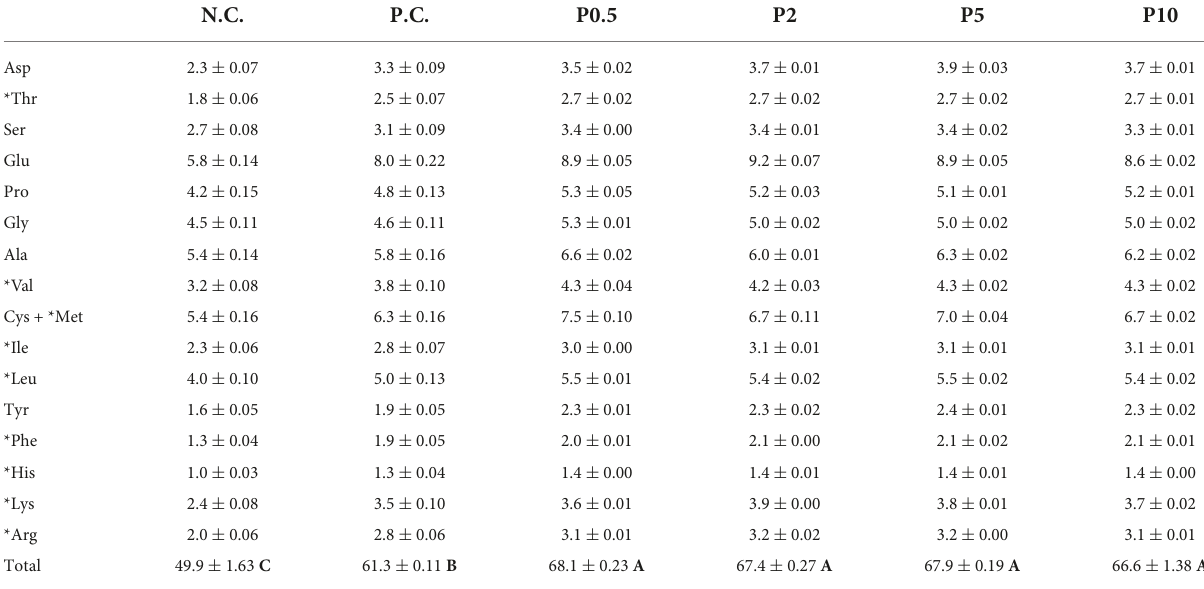
TABLE 3 Total amino acid content and composition (mean ± SE g/100 g DM) in the head in caged honey bees fed with different diets on day 12. N.C.